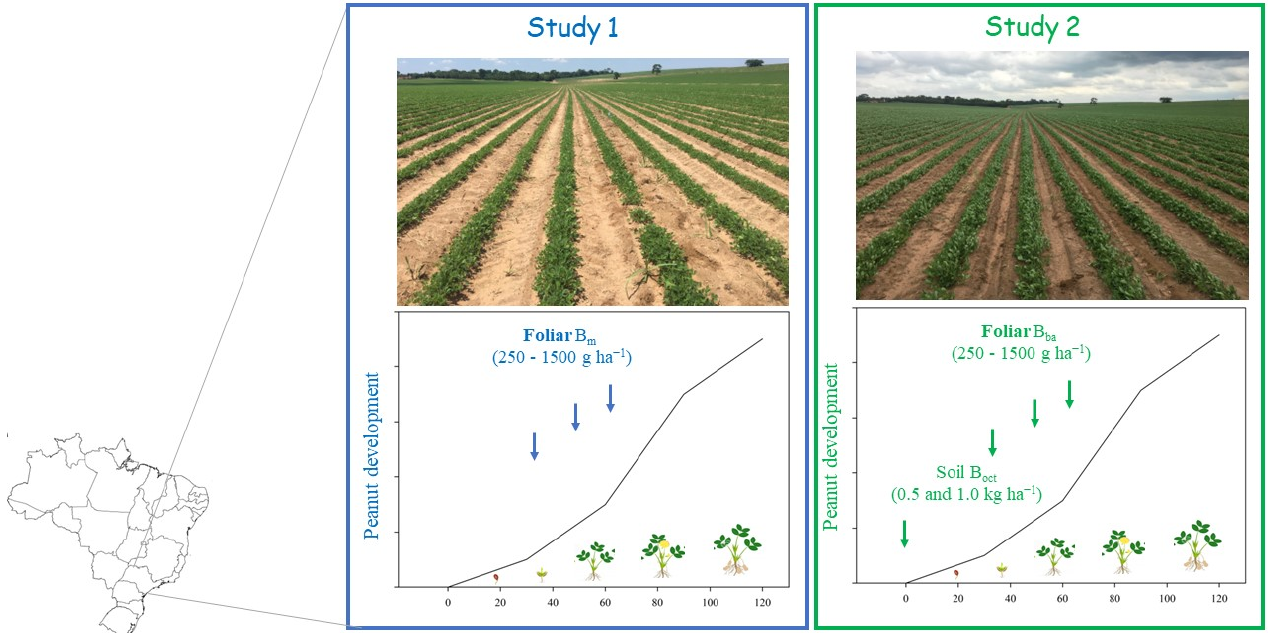
Figure 2. Study 1 with foliar application of B (Bm, monoethanolamine) using six B rates (250, 500, 750, 1000, 1250, and 1500 g ha − 1 ), and Study 2, with B application in soil using sodium octaborate (Boct) with two rates (Boct0.5: 0.5 kg ha − 1 ; and Boct1.0: 1.0 kg ha − 1 ), and the foliar B application using boric acid (Bba) with six rates (250, 500, 750, 1000, 1250, and 1500 g ha − 1 ).